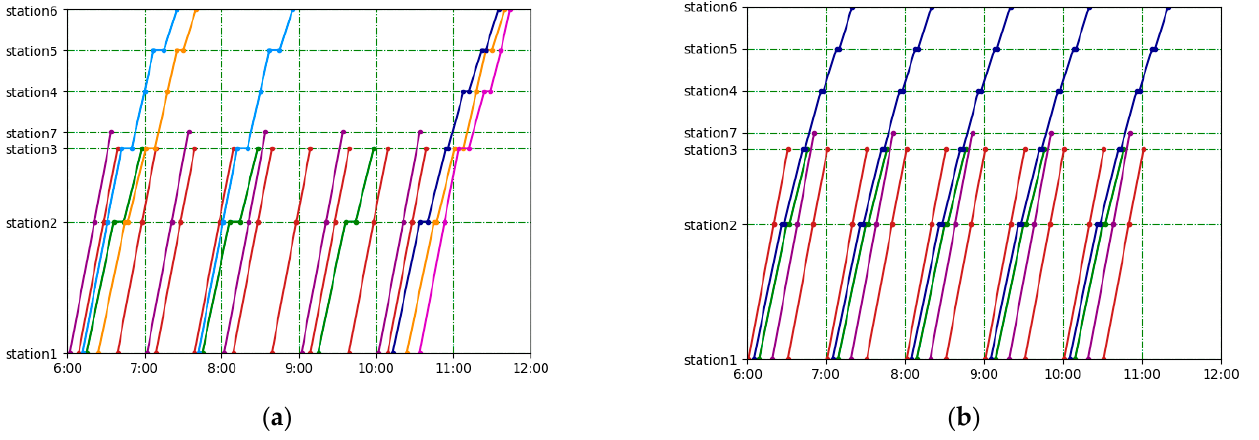
Figure 4. Multi-cycle train timetable and single-cycle train timetable under scenario 1. ( a ) Multi-cycle train timetable. ( b ) Single-cycle train timetable. Red, green, blue, orange, violet, navy blue and purple represents Line 1, 2, 3, 4, 5, 7 and 10 in Table 3, respectively.